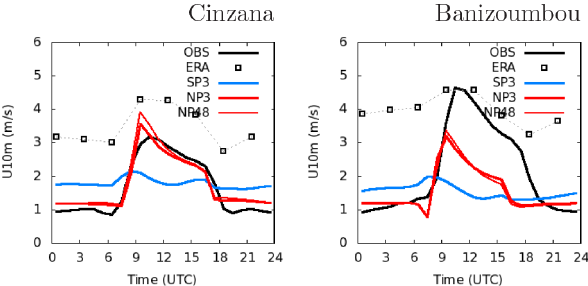
Figure 7. Wind mean diurnal cycle for JFM 2006 (ms − 1 ) for the Cinzana (left) and Banizoumbou (right) stations. Model results (col- ored curves) are compared to observations (black curve) and ERAI reanalyses (squares) for the same time period. Note that the univer- sal and local times do not depart by more than 1h for the region considered